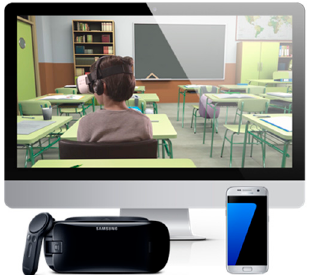
Figure 2. Aula Nesplora (virtual reality continuous performance test) hardware.